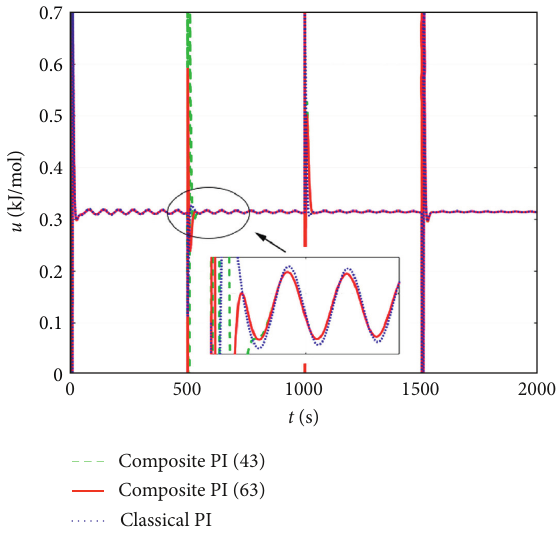
Figure 11: The profiles of the control input by classical PI and composite PI ((37) and (57)) for the small variation of temperature regulation.